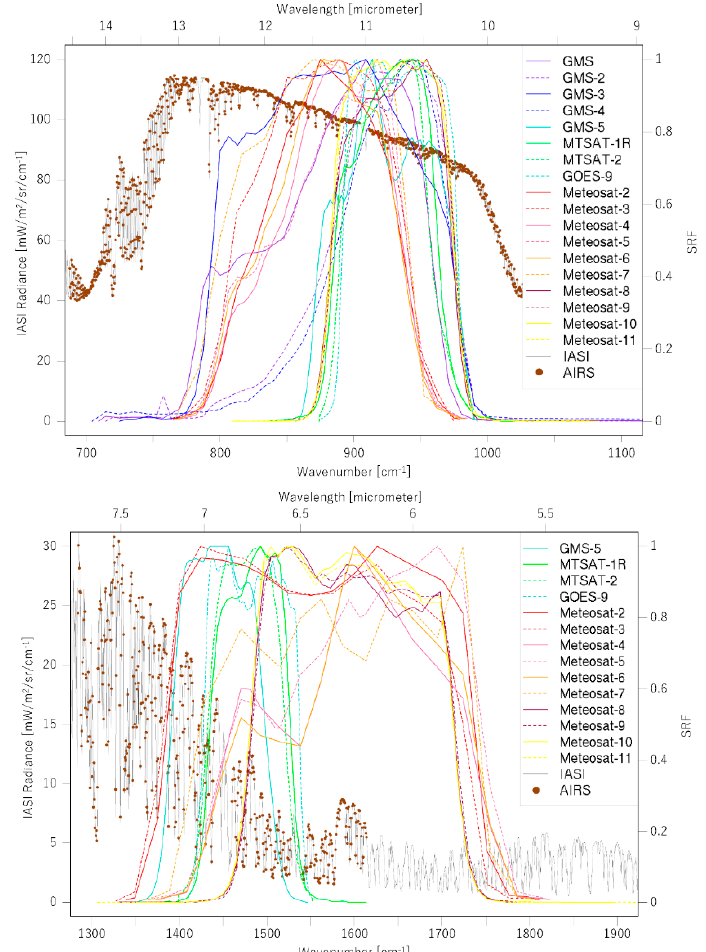
Figure 1. Spectral response functions for (top) IR and (bottom) WV channels on EUMETSAT and JMA geostationary satellites considered in this study. Infrared Atmospheric Sounding Interferometer (IASI) spectra are also shown to illustrate atmospheric opaqueness at these spectral regimes. Brown dots represents spectral sampling of Atmospheric Infrared Sounder (AIRS) measurements. Two small gaps in the AIRS spectra are visible in the IR channel spectral range, but there are large gaps in the WV spectral range, which requires some additional processing before these spectra can be used for the recalibration of IR and WV channel measurements.